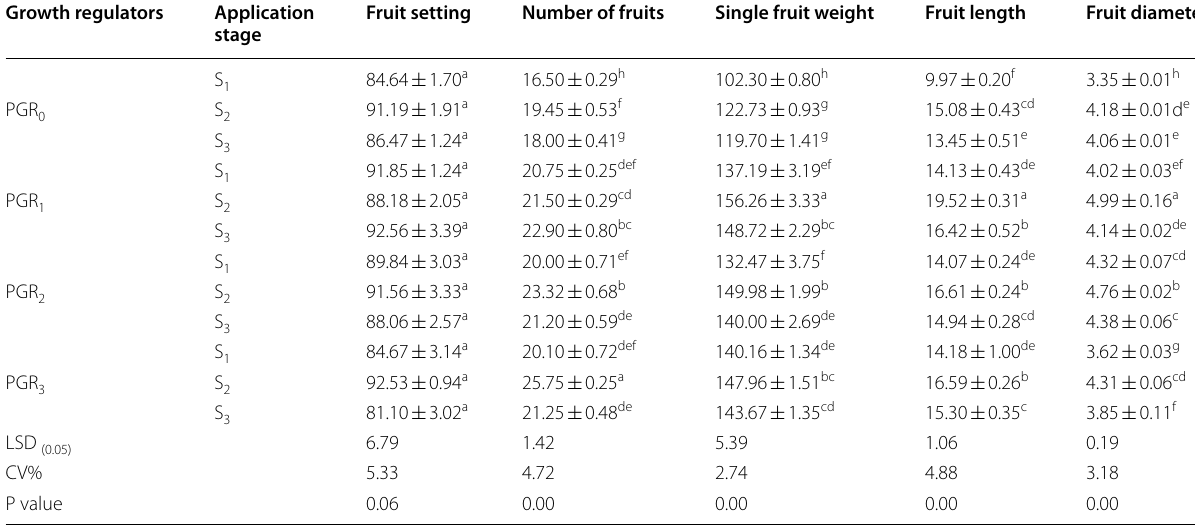
3 : flower bud stage. Different letters in the same column indicate significant differences between treatments ( p < 0.05). Values are mean ± SE Table 4 Influenced of different plant growth regulators on fruit setting (%), number of fruits (plant − 1 ), single fruit weight (g), fruit length (cm) and fruit diameter (cm) at various application stages in bitter gourd Growth